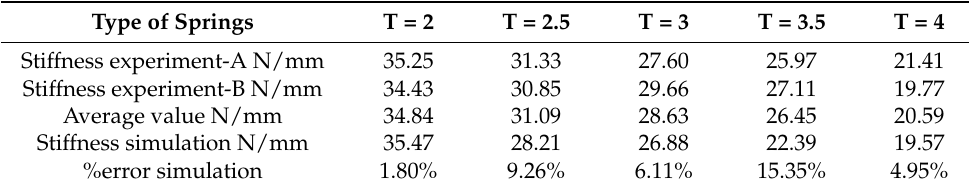
Figure 10. Load-displacement curve of simulation and experiment. Table 4. Summary of the Stiffness results on GFRP wave springs. Table 4. Summary of the Stiffness results on GFRP wave